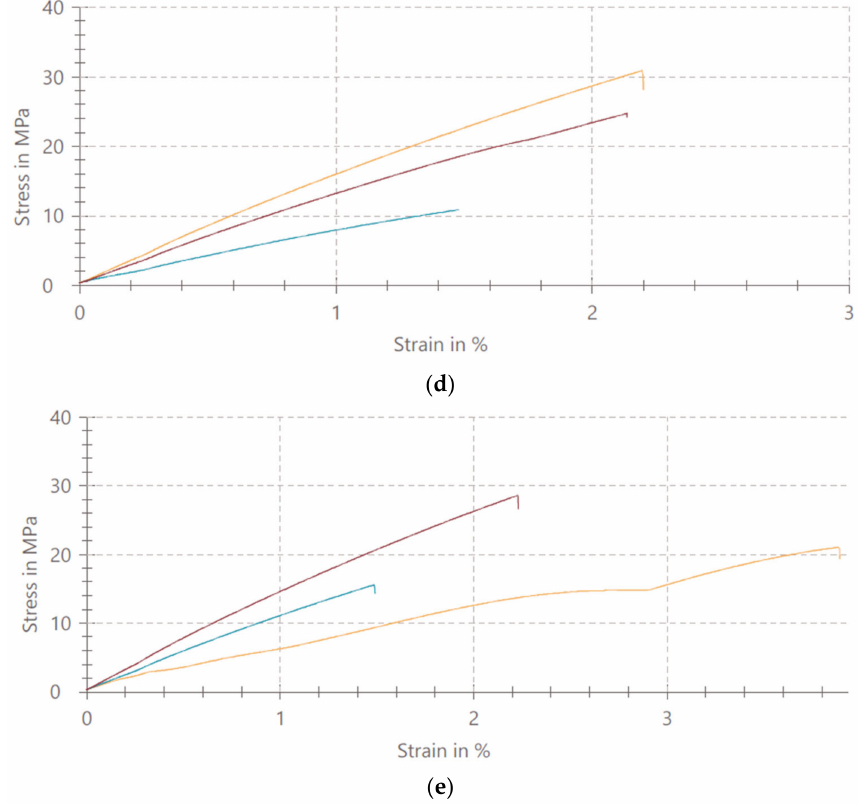
Figure 1. The stress–strain curves of tensile test for ( a ) PMMA, ( b ) PMMA/TiO 2 NPs (1%),